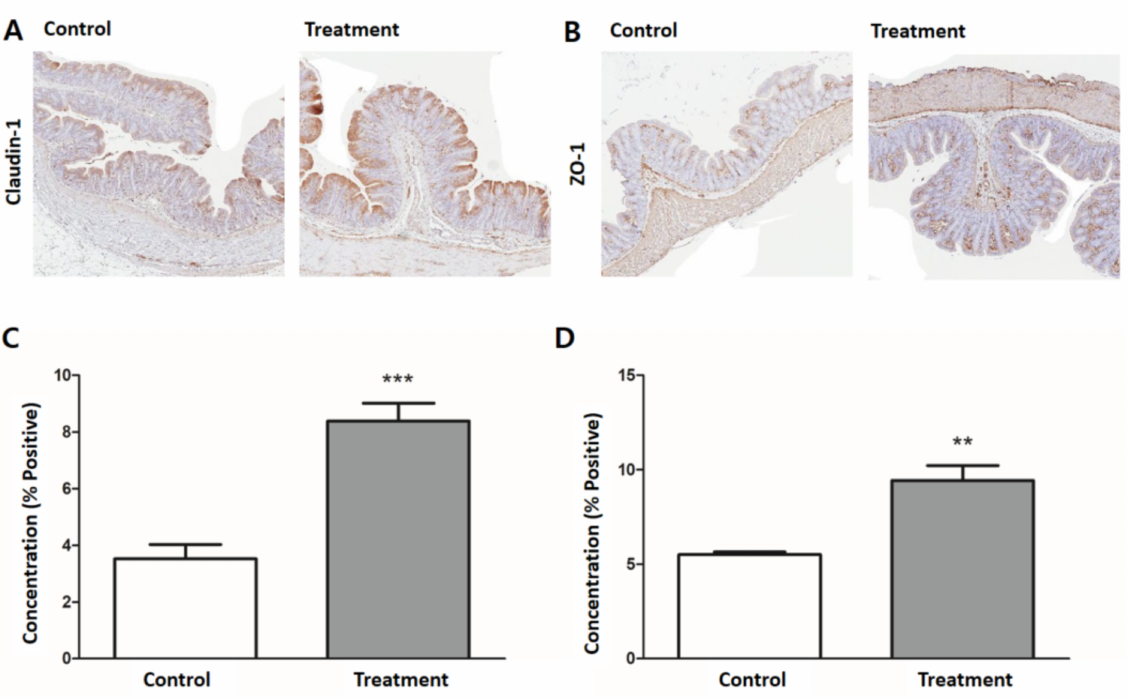
Figure 6. Expression of colonic tight junction proteins. Representative H&E-stained images of colon tissue for ( A ) claudin-1 and ( B ) ZO-1 by immunohistochemistry (200 × magnification). Quantification of ( C ) claudin-1 and ( D ) ZO-1 expression were significantly higher in the treatment group (gray bar) than the control group (white bar). Results are expressed as mean ± SEM ( n = 7/group). ** p < 0.01, *** p <